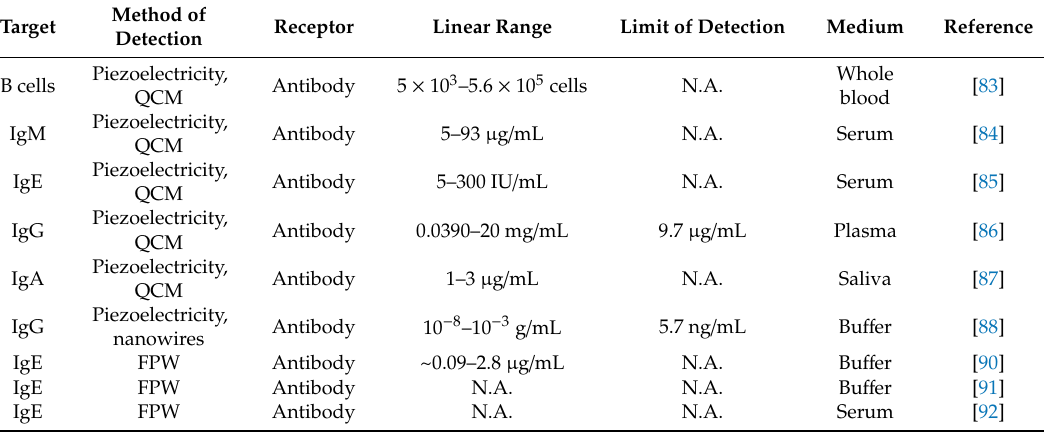
Table 4. Characteristics of the piezoelectric biosensors for detecting B cells and immunoglobulins (N.A., not available). QCM: quartz crystal microbalance and FPW: flexural plate